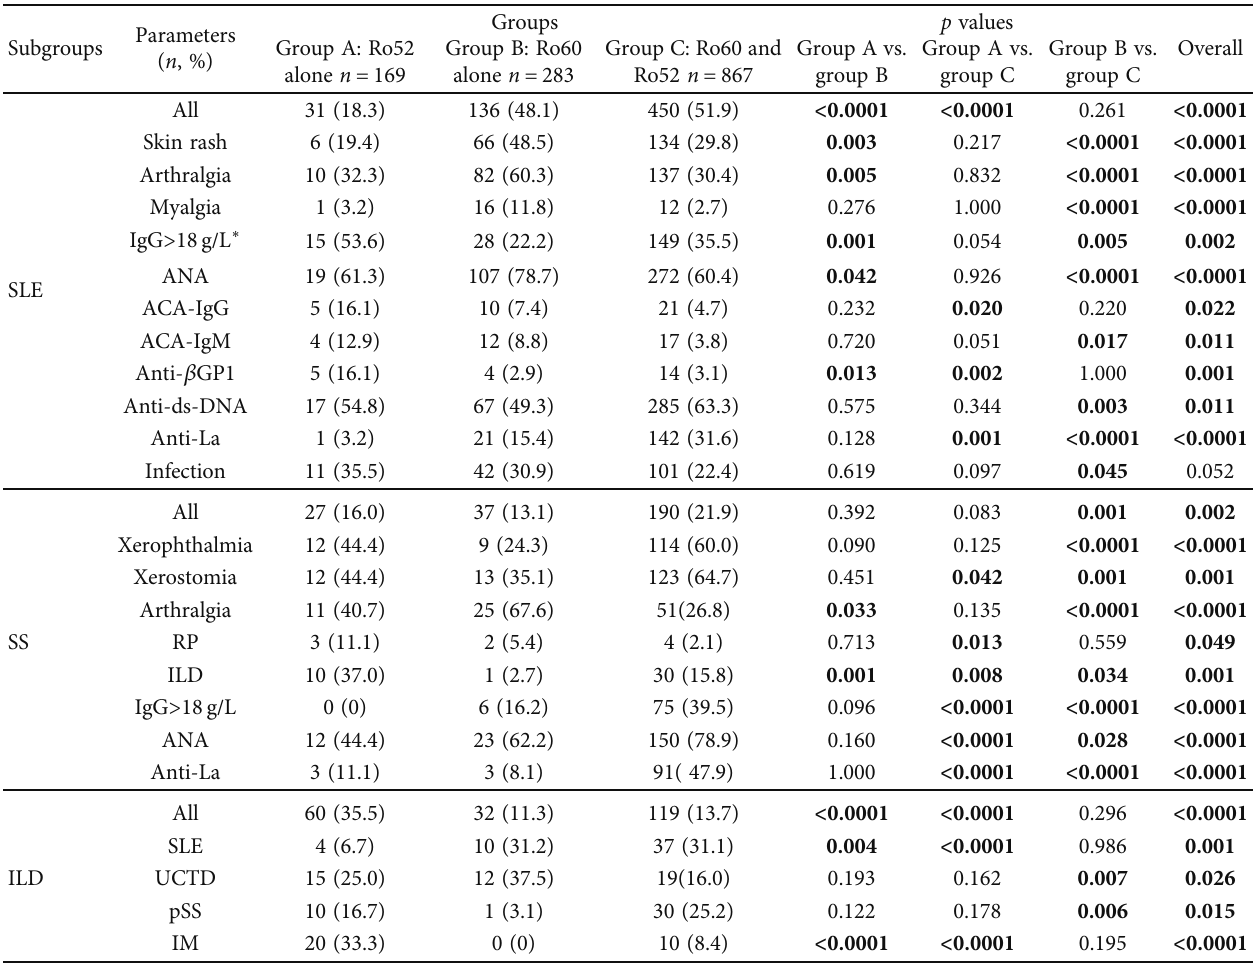
Table 5: Subgroup analyses of patients with di ff erent connective tissue